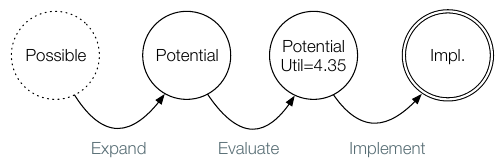
Figure 3. States and operations on a single node in the feature tree. Potential nodes are expanded into Possible nodes, which can be evaluated against user preferences, before being implemented